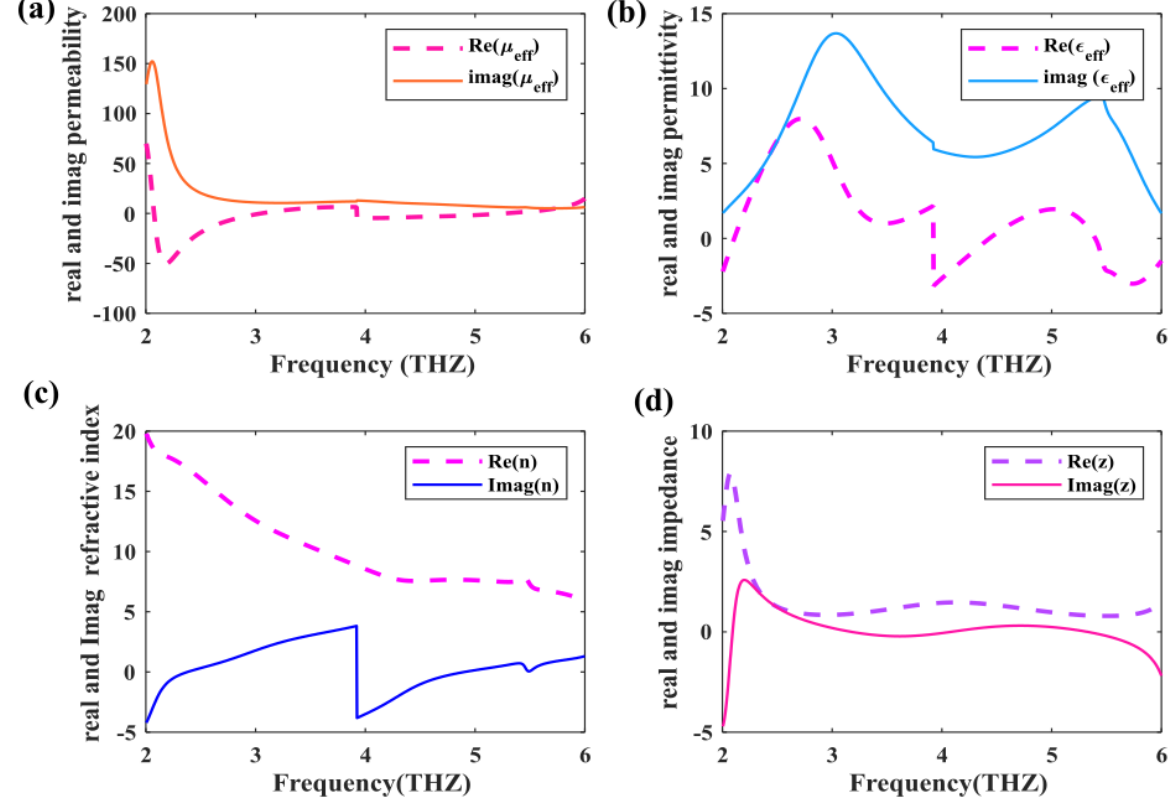
Figure 7. When σ = 2 × 10 5 S/m, the effective physical parameters of ( a ) permittivity of the design structure, ( b ) permeability of the design structure, ( c ) refractive index of the design structure, and ( d ) impedance of the design absorber are obtained.